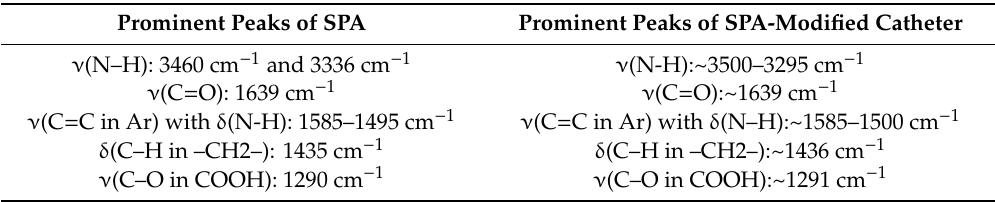
Table 2. Summary of the FTIR analysis of SPA-modified catheter following the SPA-M2 method. Prominent Peaks of SPA Prominent Peaks of SPA-Modified Catheter